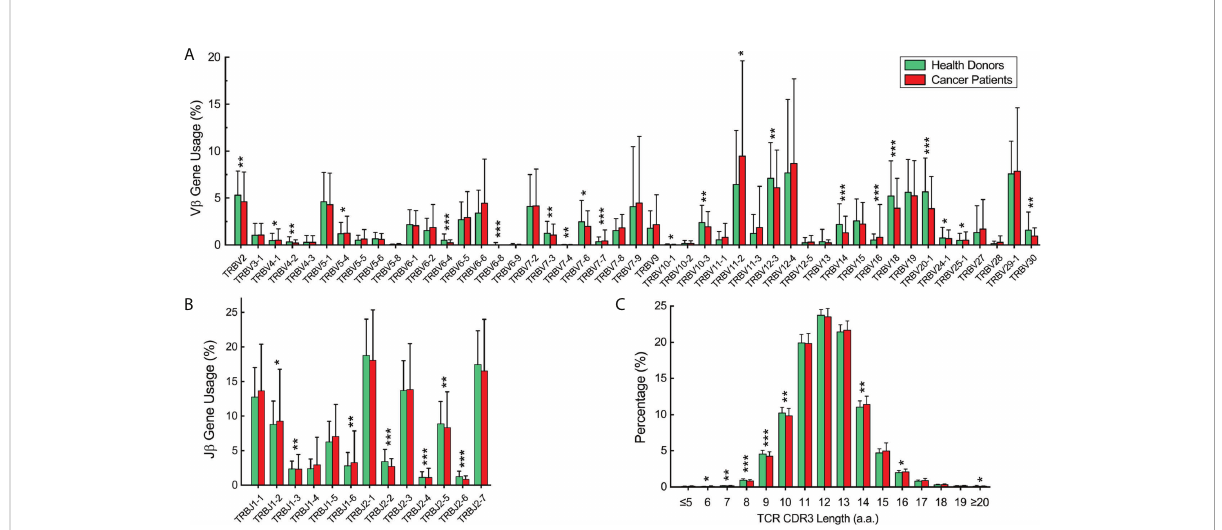
FIGURE 1 V b and J b gene usage and complementarity-determining region 3 (CDR3) length distribution of the expressed T-cell receptor (TCR) b repertoires in the peripheral blood of healthy donors and cancer patients. (A) V b gene usage comparison. The x-axis depicts all functional human TRBV alleles while the y ‐ axis is the percentage of TCR b sequences in all repertoires of healthy donors or cancer patients using each TRBV allele. (B) J b gene usage comparison. The x-axis depicts functional human T-cell Receptor Beta Joining (TRBJ) alleles. (C) TCR b CDR3 amino acid sequence length distribution comparison. The y ‐ axis is the percentage of TCR b CDR3 clone types with the corresponding CDR3 length. The error bars indicate standard deviations while the asterisks indicate p -values of the Mann-Whitney U test (* p < 0.05; ** p < 0.01; *** p <